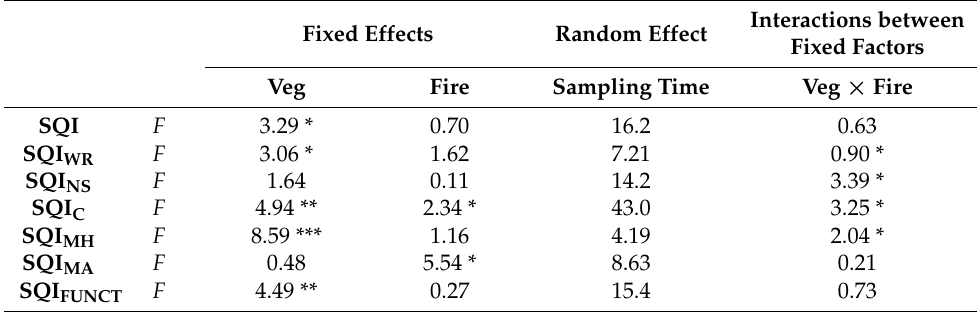
Table 5. Summary of mixed-effect model analyses (F-value: F ) between vegetation cover type (Veg) and fire (Fire) as fixed effects and sampling time as random effect, on soil quality indices (simple additive soil quality indices: SQI, water retention soil quality index—SQI WR , nutrient supply